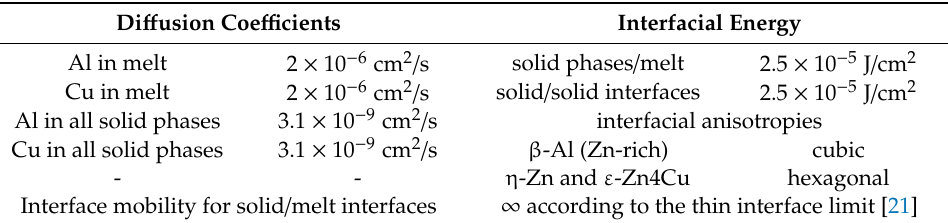
Table 1. Material parameters used for the phase-field